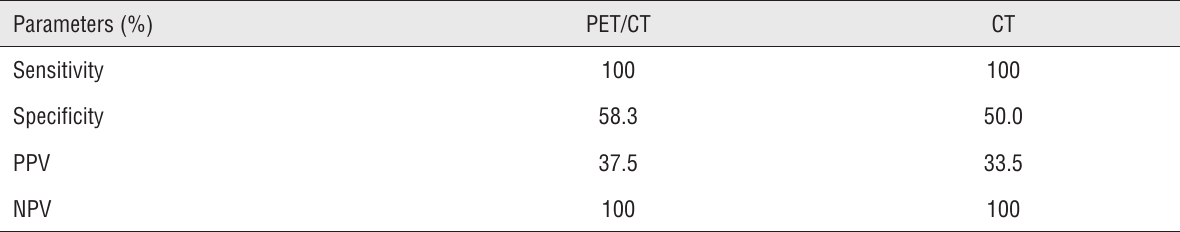
Table 2 = Comparison of pET/CT versus CT in terms of nodal detection.